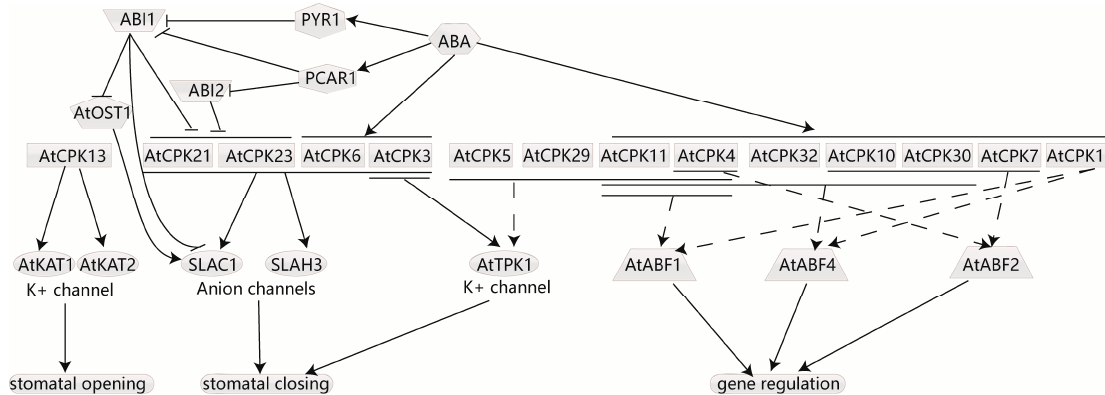
Figure 3. CDPKs involve ABA-induced stomata movements and phosphorylate ABFs. CDPKs participate in ABA signal transduction by affecting the activity of ABA-responsive element-binding factors/proteins (ABFs) and are involved in ABA-dependent stomata movement. Many CDPKs in Arabidopsis have been found to phosphorylate ABFs in vitro, but evidence in vivo is lacking. CDPKs phosphorylate K + channel (AtTPK1) and anion channels (SLAC1 and SLAH3), triggering the release of K + and anions from guard cells, resulting in stomatal closure. Some phosphorylate two inward K + channels (AtKAT1 and AtKAT2) and inhibit their activity, leading to stomatal opening. PYR/PYL/RCAR–PP2Cs–SnRK2s is the core signaling pathway of ABA from ABA perception to ABA-regulated gene expression. The dashed lines represent that there is only evidence in vitro. Arrows indicate promotion, and T bars indicate suppression.